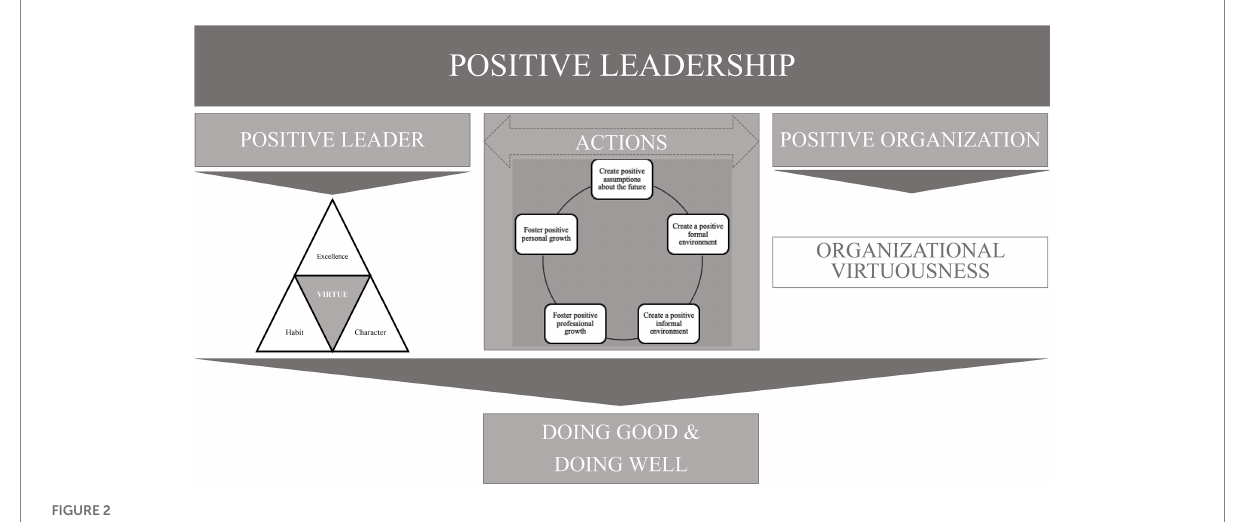
FIGURE 2 Detailed positive leadership action framework